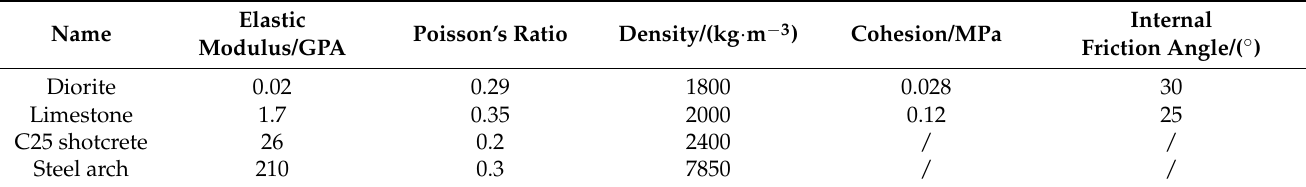
Table 2. Tunnel model